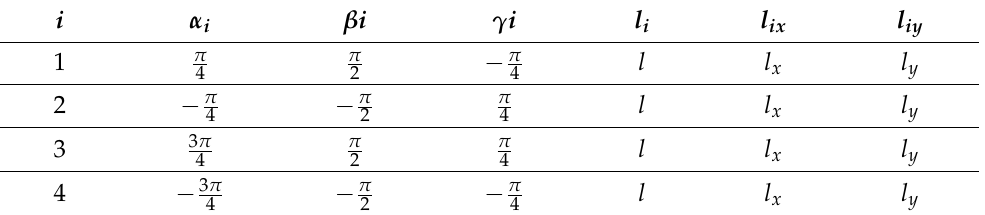
Table 2. Parameters of the Wasp platform.